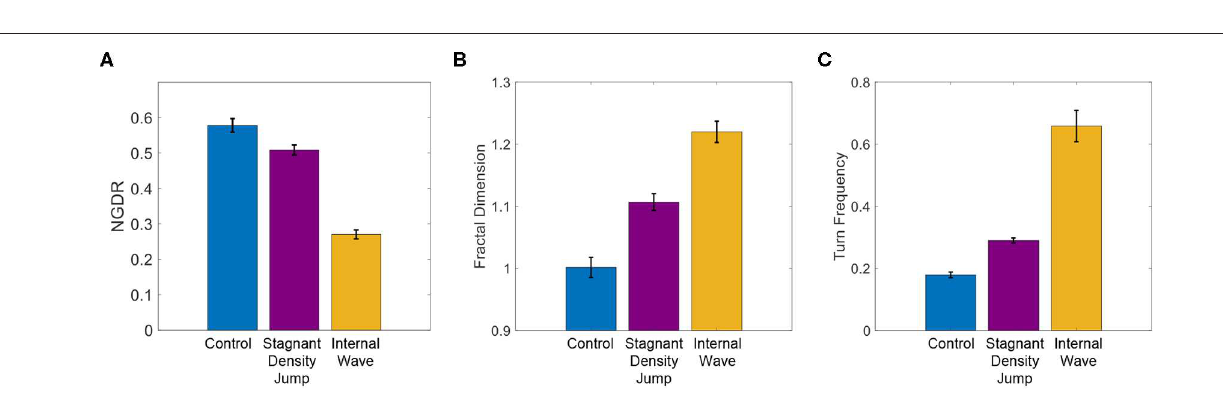
FIGURE 9 | (A) Net-to-gross-displacement-ratio (NGDR), (B) fractal dimension, and (C) turn frequency (turns per copepod per second) for the swimming trajectories for the control, stagnant density jump, and internal wave treatments. The error bars span ± one standard